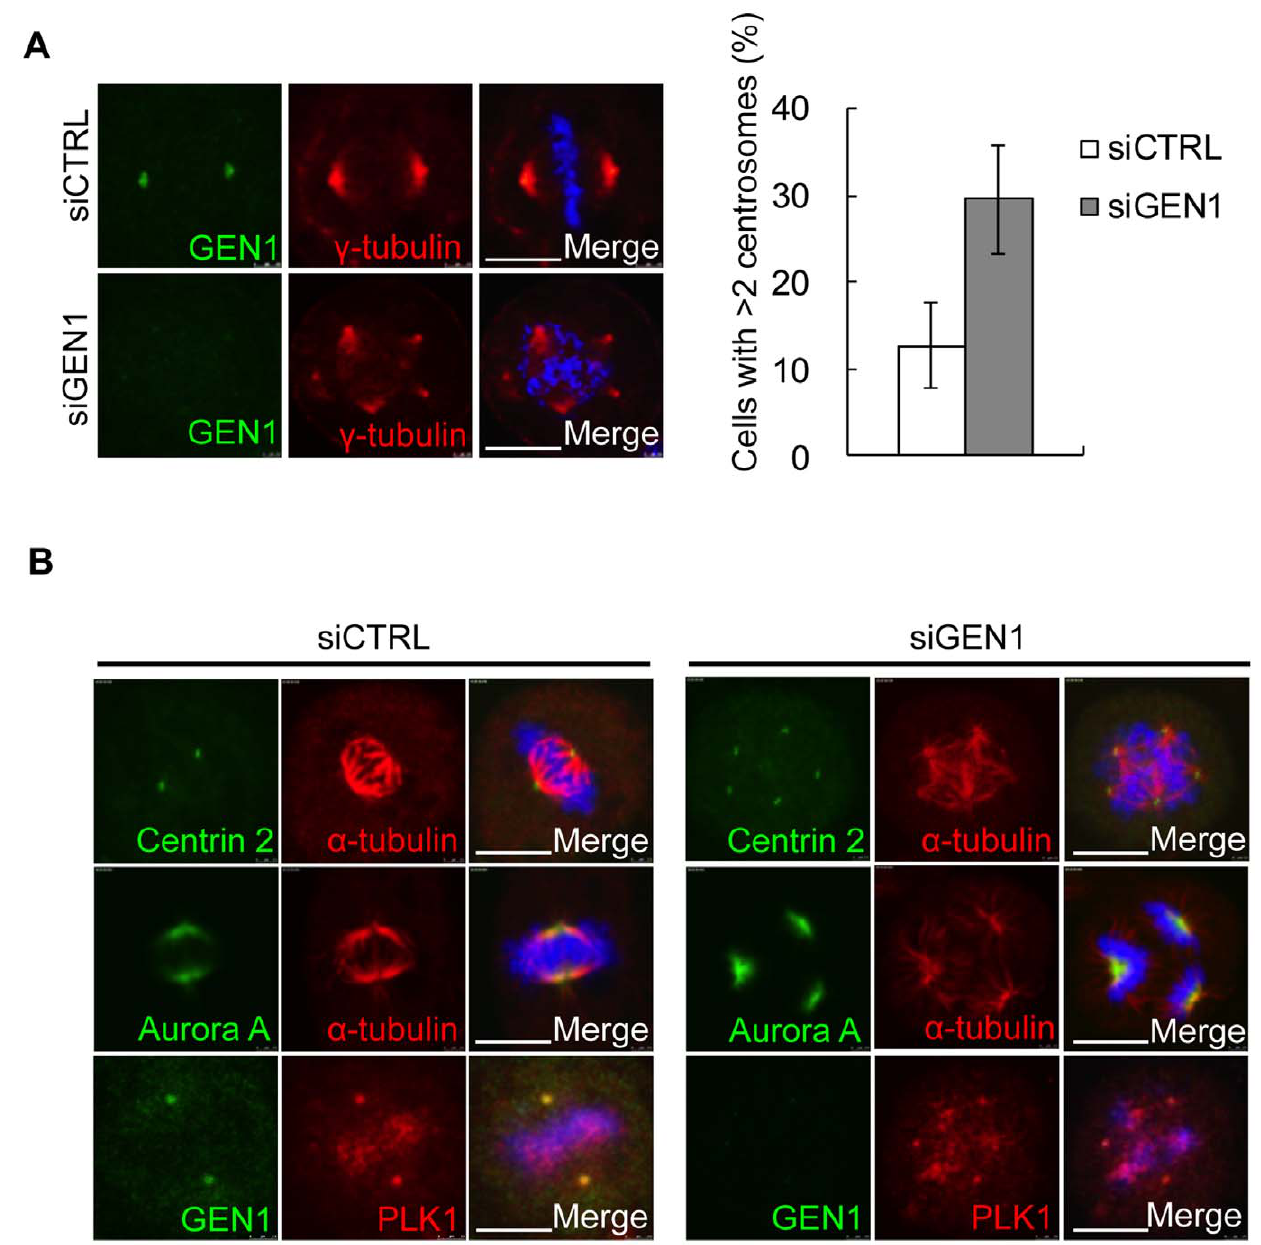
Figure 2. GEN1 deficiency leads to supernumerary centrosomes in mitosis. A. (left) HeLa cells were treated with GEN1 or control (CTRL) siRNA for 48 h, methanol fixed and immunostained with the indicated antibodies. (right) Graph represents the mean of three independent experiments. (n=300 cells/condition/experiment). Scale bar, 10 m m. B. HeLa cells treated with CTRL or GEN1 siRNA were methanol fixed and immunostained with anti-GEN1 (651–892aa) antibody and anti- c -tubulin antibody. Scale bars, 10 m